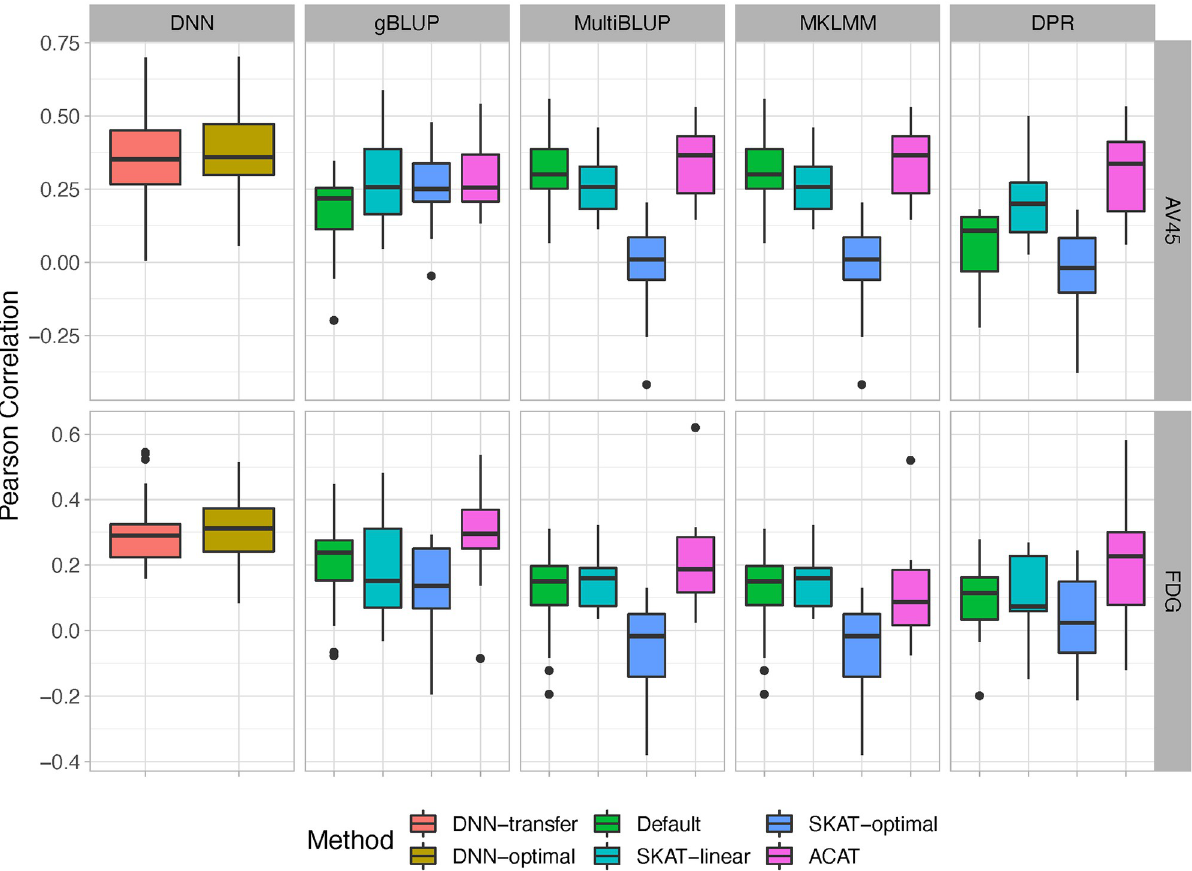
Fig 7. The Pearson correlations between the predicted and observed values for AV45 and FDG. Genes are pre-selected under the p-value threshold of 0.001 for DNN-transfer, SKAT-linear, SKAT-optimal and ACAT.